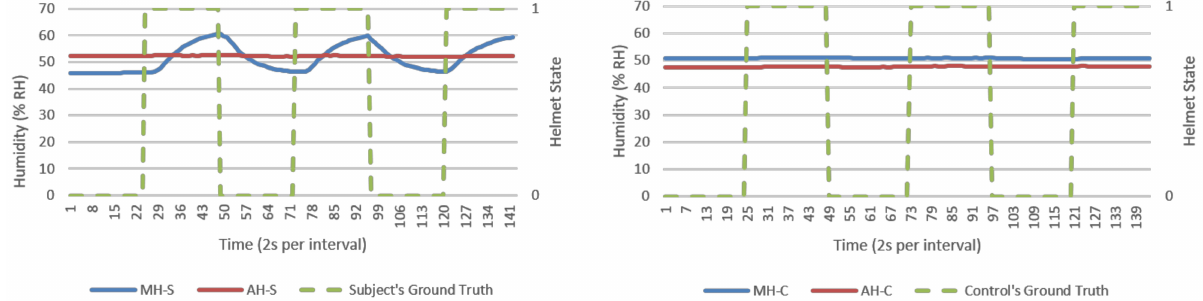
Figure 7. Relative humidity (% RH) versus time (2 s per interval) data logs from a typical NM run, human subject ( left ), and experiment control ( right ). Helmet state 0 = NW and 1 = W.